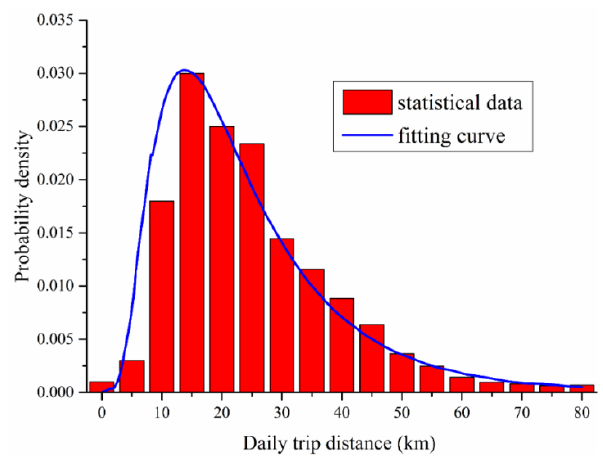
Figure 3. The daily trip distance.